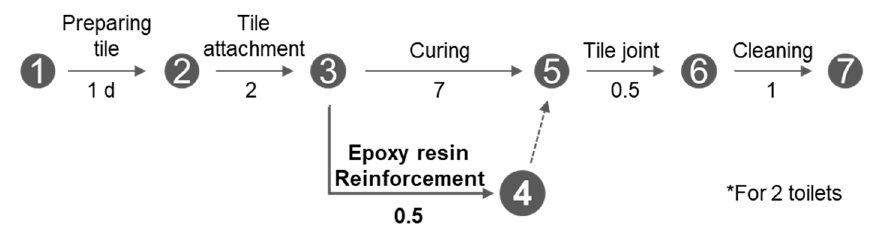
Figure 2. Process of epoxy resin reinforcement.